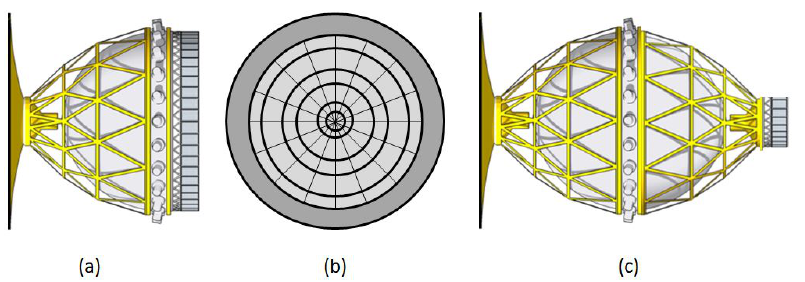
Figure 4. Reaction chamber of fusion engines: ( a ) open hemispherical shell, ( b ) internal geometry of target chamber, ( c ) closed